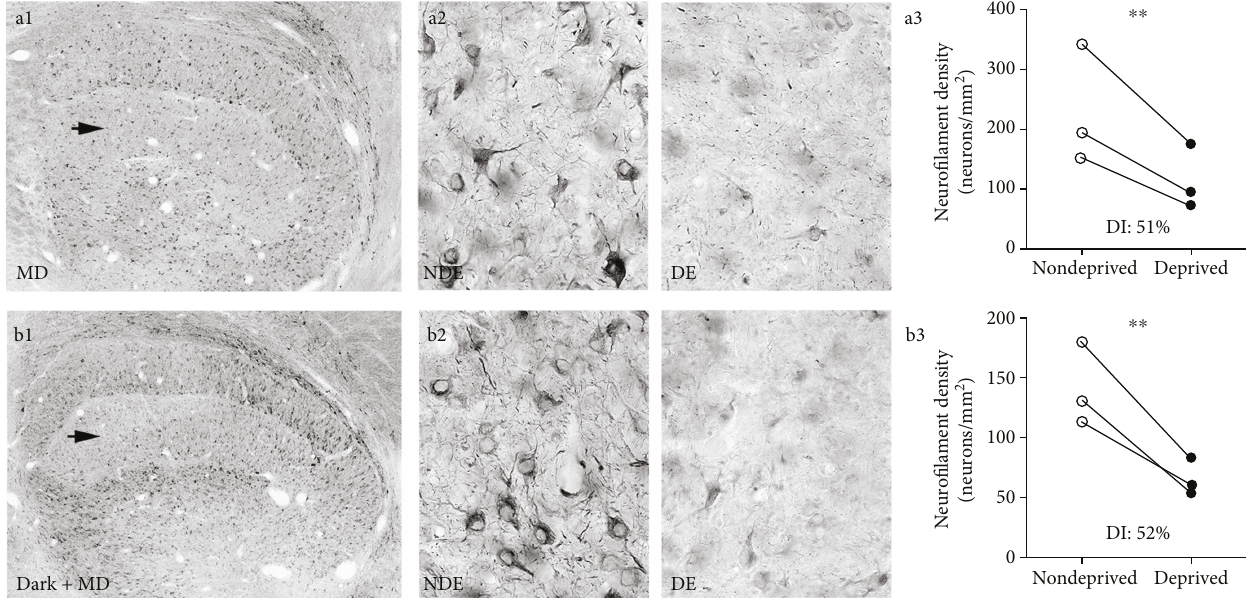
Figure 3: Examination of the magnitude of neuro fi lament loss in the dLGN from animals that were either monocularly deprived for 7 days at the peak of the critical period or else received 10 days of dark exposure before the same length of MD. Monocular deprivation alone produced a substantial reduction in the amount of neuro fi lament labeling within deprived-eye dLGN layers (a1). At high magni fi cation, the loss of labeling was evident as a reduced number of immunopositive neurons, as well as a reduction in labeling intensity (a2) in deprived-eye (DE) relative to non-deprived-eye (NDE) layers. When the same MD was preceded by 10 days of darkness, a similar reduction in neuro fi lament within deprived-eye layers was observed at low (b1) as well as at high magni fi cation (b2). Stereological quanti fi cation of the density of neuro fi lament-positive neurons revealed that MD-only (a3) and MD preceded by dark exposure (b3) produced a similar deprivation e ff ect, each with a signi fi cant reduction in deprived layers. Arrows in (a1) and (b1) indicate the deprived-eye layer. Asterisks indicate statistical signi fi cance at probability < 0 05 . Scale bars = 500 μ m (1) and 50 μ m (2).